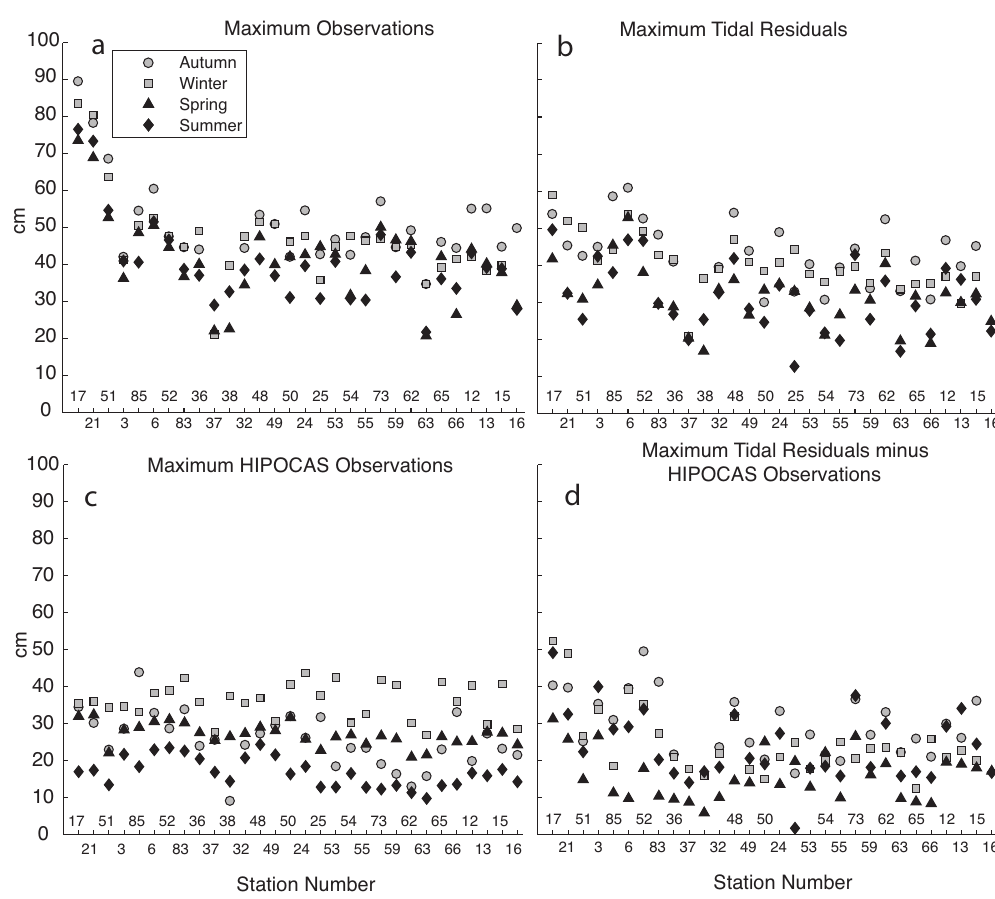
Fig. 4. As Fig. 3 for the western Mediterranean Figure 4. As Figure 3 for the western Mediterranean tide-gauges.